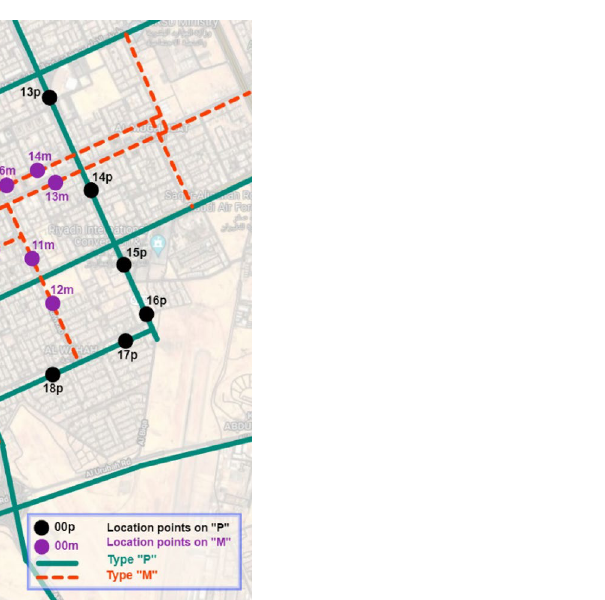
Figure 4. Study zone embraced in the field assessment. ( A ) Selected roads along routes that pedestrians could use for traveling to PSU. ( B ) Study zone dimensions and partially operated bus stations (PIXLR X, https:// pixlr. com/x/).